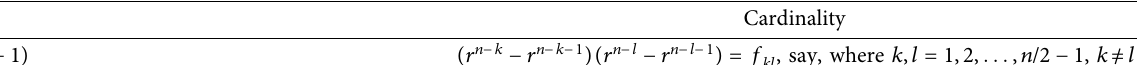
Table 9: Partition of pair of nodes ( u,v ) having distance 2.